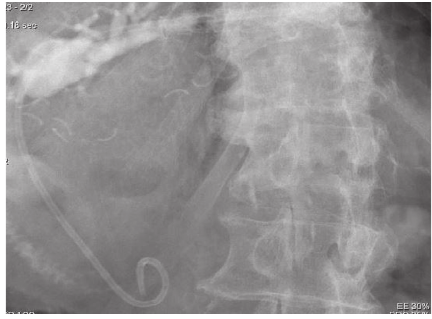
Figure 5: EUS-HG with placement of metal and double pigtail plastic stents.